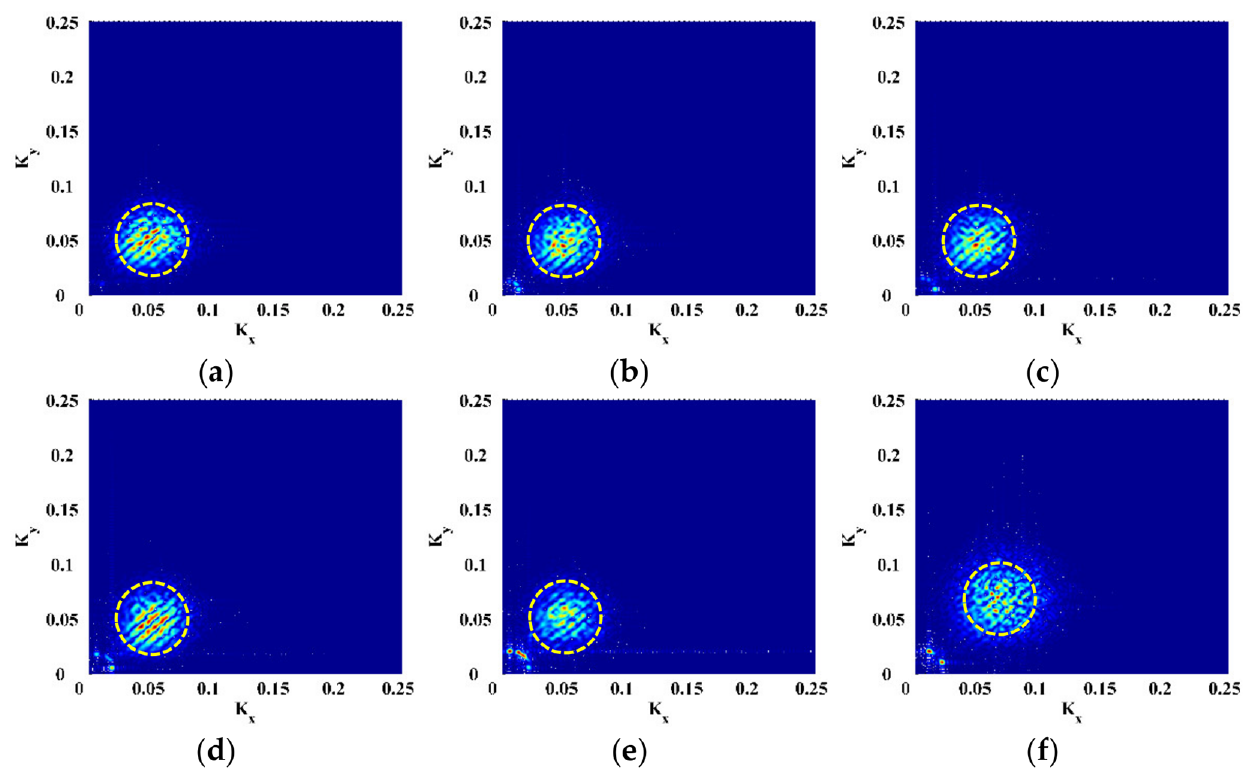
Figure 6. EMDIs for Scenarios ( a ) I, ( b ) II, ( c ) III, ( d ) IV, ( e ) V, and (f) VI.